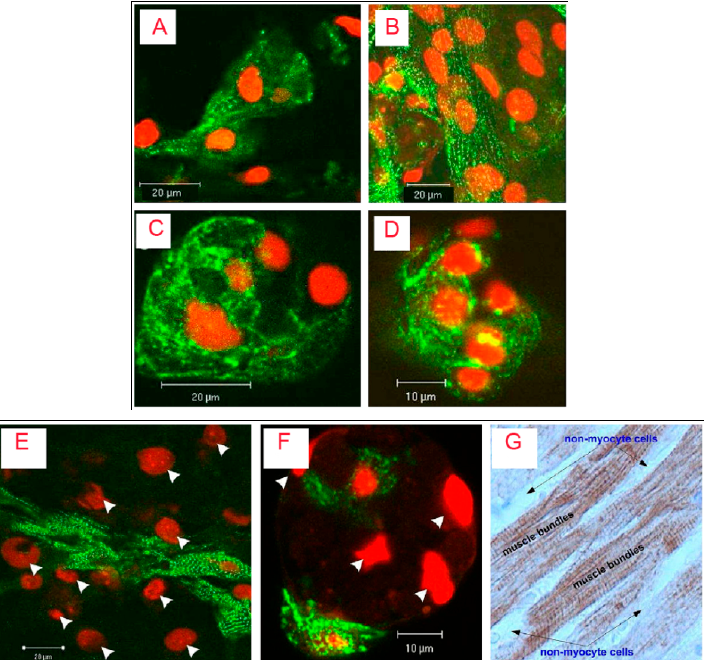
Figure 2. Confocal microscopy and immune histochemistry images of cardiac cells cultivated in RGD-immobilized ( A , B ) and unmodified ALG scaffolds ( C , D ) for 6 ( A , C ) and 12 ( B , D ) days. The constructs were immune stained for a-actinin (green) and nuclei (red-propidium iodide). Adjacent cardiomyocytes joined to form striated myofibers (Figure 2A, day 6), an occurrence that increased in frequency as cultivation proceeded (Figure 2B, day 12). In contrast, cardiomyocytes cultivated within the unmodified ALG scaffolds revealed unorganized myofibrils; there were fewer interactions between adjacent cardiomyocytes and myofibers were not detected (Figure 2C and D, days 6 and 12, respectively). The lower panel shows relative locations of cardiomyocytes and nonmyocyte cells (NMCs) in ( E ) RGD-immobilized and ( F ) unmodified ALG scaffold; ( G ) the native adult cardiac tissue. In E and F, only cardiomyocytes were stained for α -actinin ( green ), while all cell nuclei were stained with propidium iodide (Red). Arrow heads denote cell nuclei of NMCs. Twelve-day constructs were fixed, fluorescently stained, and examined using confocal microscopy. In G, native adult cardiac tissue was stained for troponin-T ( brown ). The NMCs surrounding cardiomyocyte bundles were negatively stained. Adult rat ventricles were paraffin-fixed, cross-sectioned, and immunostained for troponin-T. Reproduced and modified with permission from Elsevier (2011)